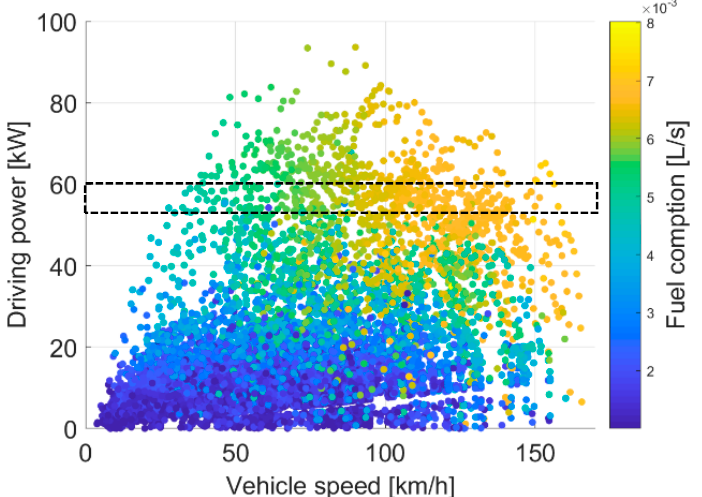
Figure 3. Analysis of the fuel consumption characteristics based on the conventional vehicle-specific power (VSP) fuel consumption modeling method.